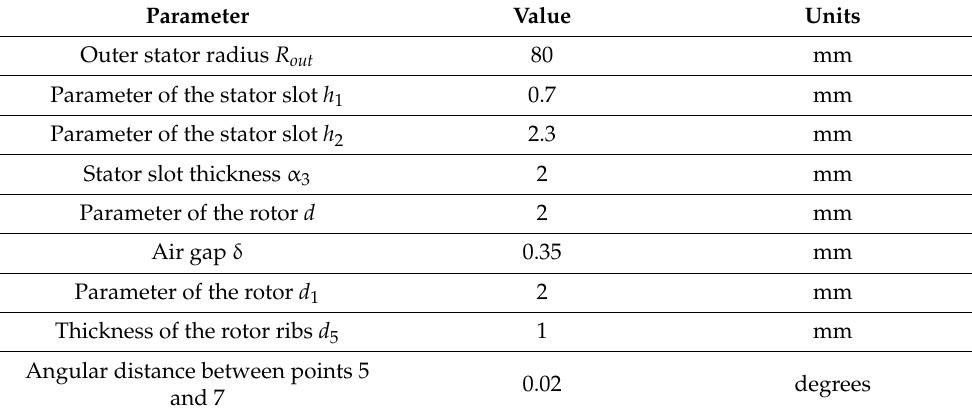
Table 6. Initial values of the IPMSM parameters varied during the optimization.